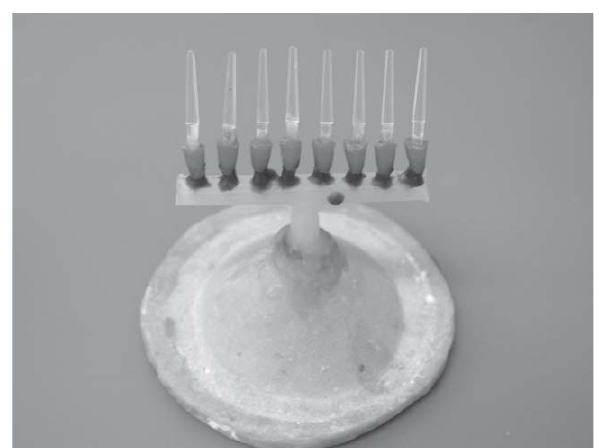
FIGURE 5- G3- 8 patterns/large